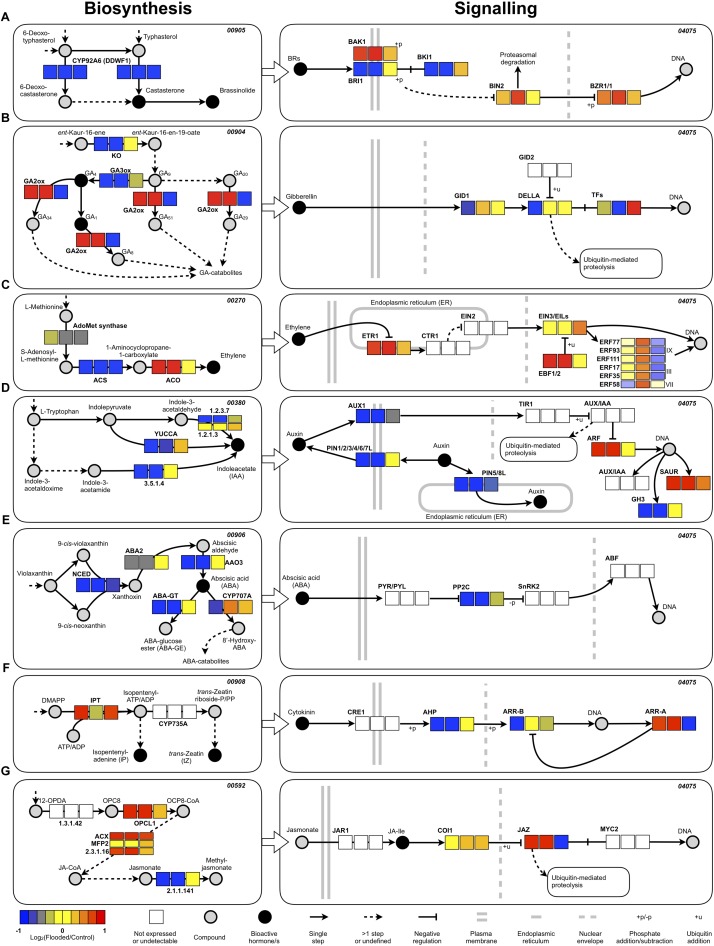
Expression patterns of the most relevant genes related to hormone biosynthesis/homeostasis, perception, and signal transduction plotted within the correspondent KEGG maps (the pathway code is also indicated at the top-right of eachmap). Only the most relevant part of the pathways of brassinosteroids (A), gibberellins (B), ethylene (C), auxin (D), abscisic acid (E), cytokinins (F), and jasmonate (G) were extracted (the whole maps are available as Supplementary Figures S7–S14) and represented according to the standard KEGG visualization, with the same colors rendered by Pathview (Luo et al., 2017) and some slight variations (an additional legend is provided): the names of the compounds and the key enzymes/proteins are reported with regular and bold fonts, respectively. Concerning the ERFs, only those with consistent expression patterns in both years are reported along with their nomenclature (Licausi et al., 2011) and classification. The differential expression level was calculated as log2-ratio (Flooded versus Control), scale-centered for each time point, and color-coded as displayed in the legend (blue: <–1; red: >+1). Each box, representing a specific enzymatic or regulatory step, is divided in three sub-boxes representing the different time points: from left to right T1, T2, and T6.